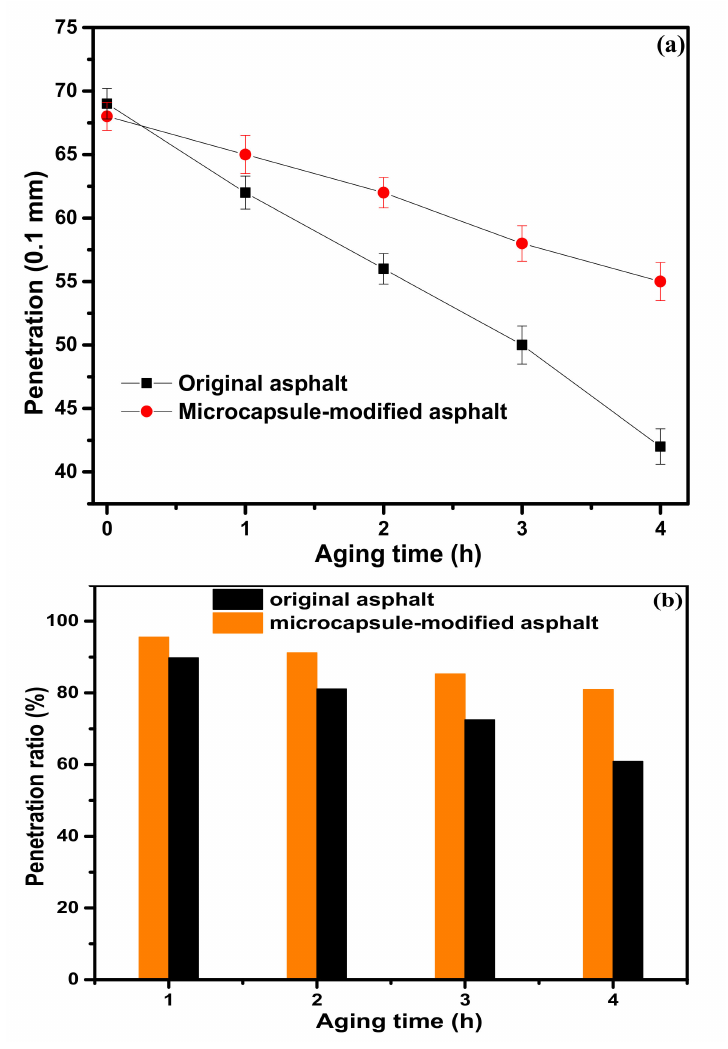
Figure 7. The penetration versus the aging time of different asphalt samples ( a ); the penetration ratio versus the aging time of different asphalt samples ( b